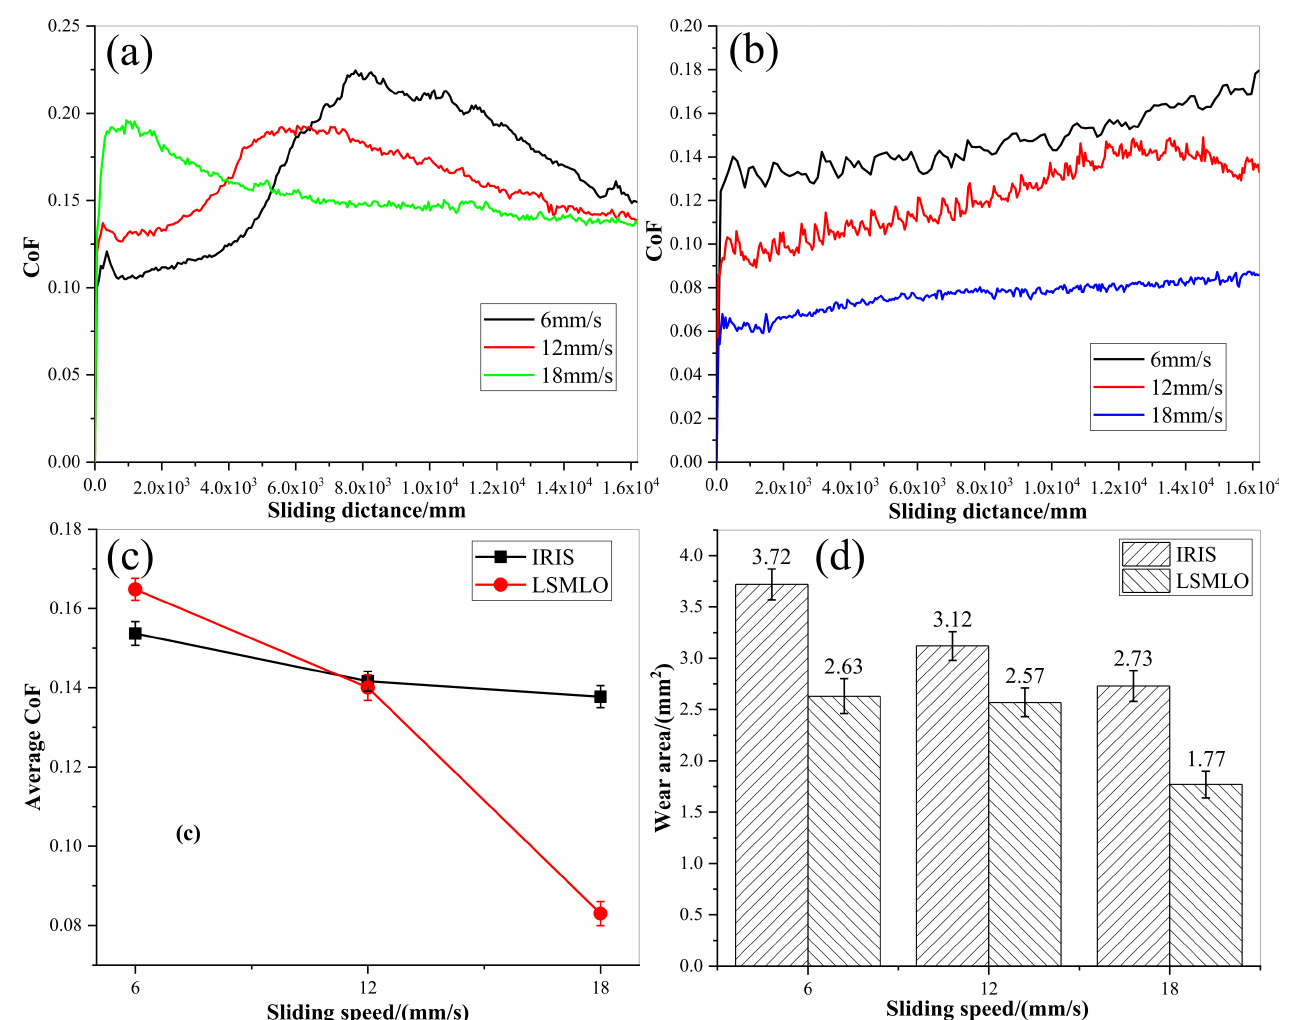
Figure 15. CoFs and wear areas of wire ropes under different sliding speeds lubricated with IRIS and LSMLO. ( a ) evolutions of CoF under IRIS lubrication; ( b ) evolutions of CoF under LSMLO lubrication; ( c ) comparison of average CoF between IRIS and LSMLO lubrication; ( d ) evolutions of wear area under IRIS and LSMLO